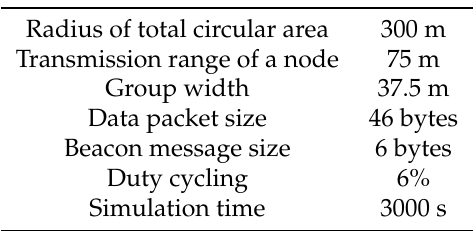
Table 1. Simulation setup.